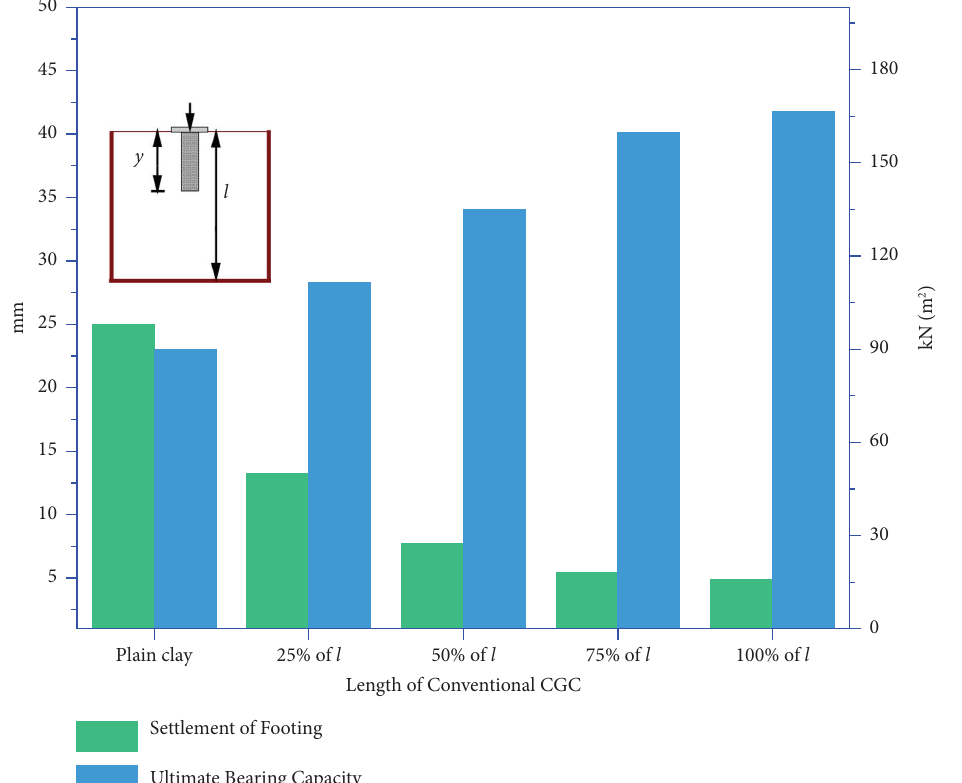
Figure 13: Efect of length of cinder gravel column on ultimate bearing capacity–settlement relationship for improved soft soil.